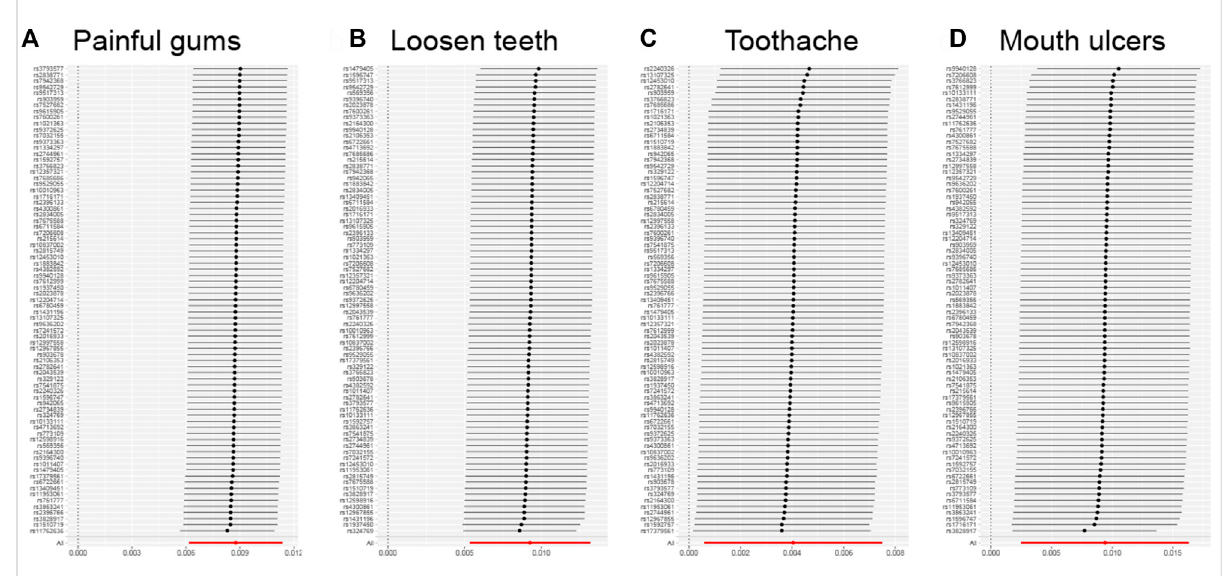
FIGURE 3 Leave-one-out analysis for the impact of individual SNPs on the association between GERD and the risk of oral lesions. (A) Painful gums, (B) Loosen teeth, (C) Toothache, (D) Mouth